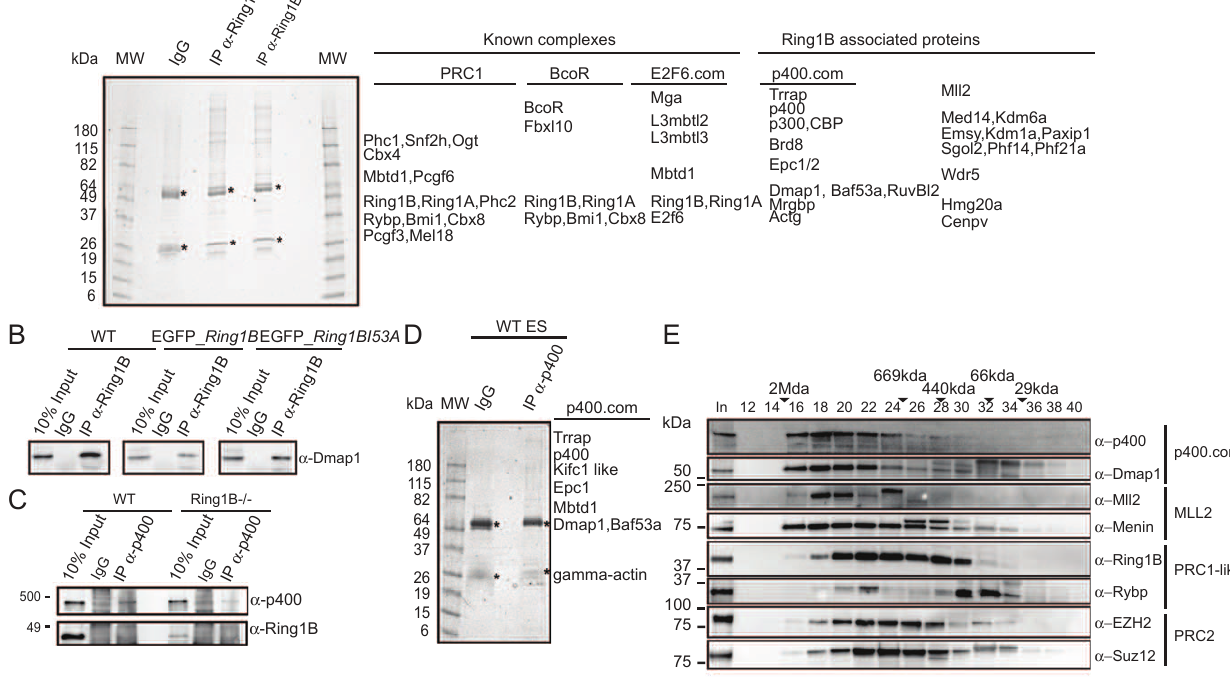
Figure 1. Identification of Ring1B associated peptides in mouse ESCs. A) IPs of Ring1B from nuclear extracts of WT and Ring1B 2 / 2 cells rescued with Ring1BI53A, resolved by 4–20% SDS-PAGE and stained with colloidal blue. Proteins that had a significant number of detected peptides by mass spectrometry analysis are listed. Peptides also detected in the control IgG lane were subtracted. Asterisks indicate the heavy and light Ig chains. B) IP of Ring1B from nuclear extracts of WT and Ring1B 2 / 2 cells rescued with full length Ring1B or Ring1BI53A resolved by 12% SDS-PAGE and immunoblotted with a -Dmap1. C) Immunoblot of p400 IP from WT and Ring1B 2 / 2 ESCs using p400 and Ring1B antibodies. D) IP of endogenous p400 from nuclear extracts of WT ESCs resolved by 4–20% SDS PAGE. Polypeptides stained by colloidal blue were identified by mass spectrometry. Listed are proteins with significant number of peptide hits. E) Size exclusion chromatography of nuclear extract from WT ESCs. Every other fraction (50%) were resolved by 4–15% SDS-PAGE and immunoblotted with anti-p400, anti-Dmap1, anti-Mll2, anti-Menin, anti-Ring1B, anti-Rybp, anti-Ezh2 and anti- Suz12. The upper panel represent fraction number, Input (In), black triangles indicate the retention of molecular weight standards in mega Dalton (MDa) or kilo Dalton (kDa).